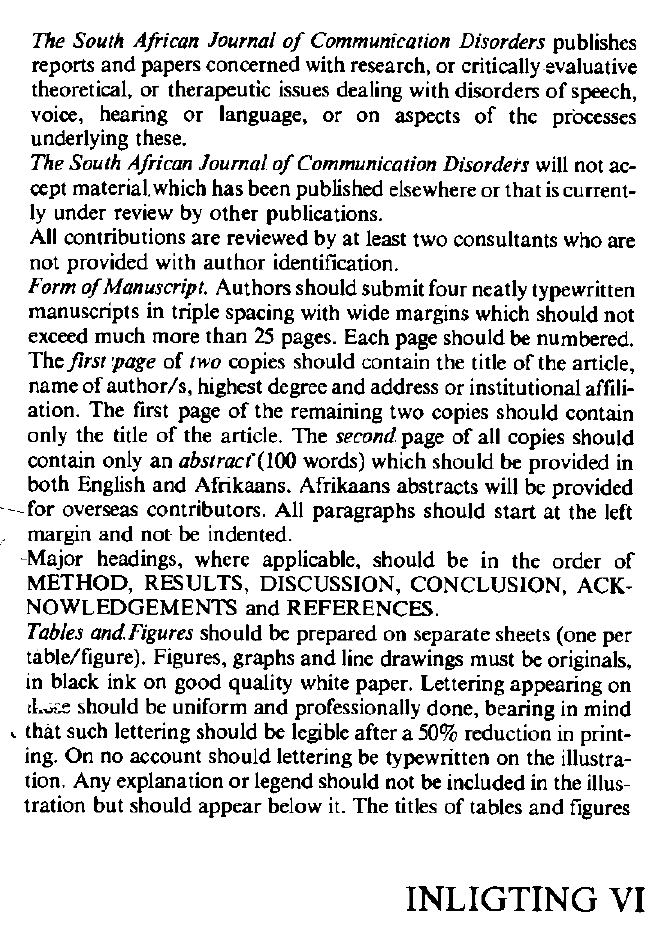
figure onderaan. Tabelle en figure moet in die volgorde waarin hulle verskyn, genommer word (met Arabiese syfers). Die